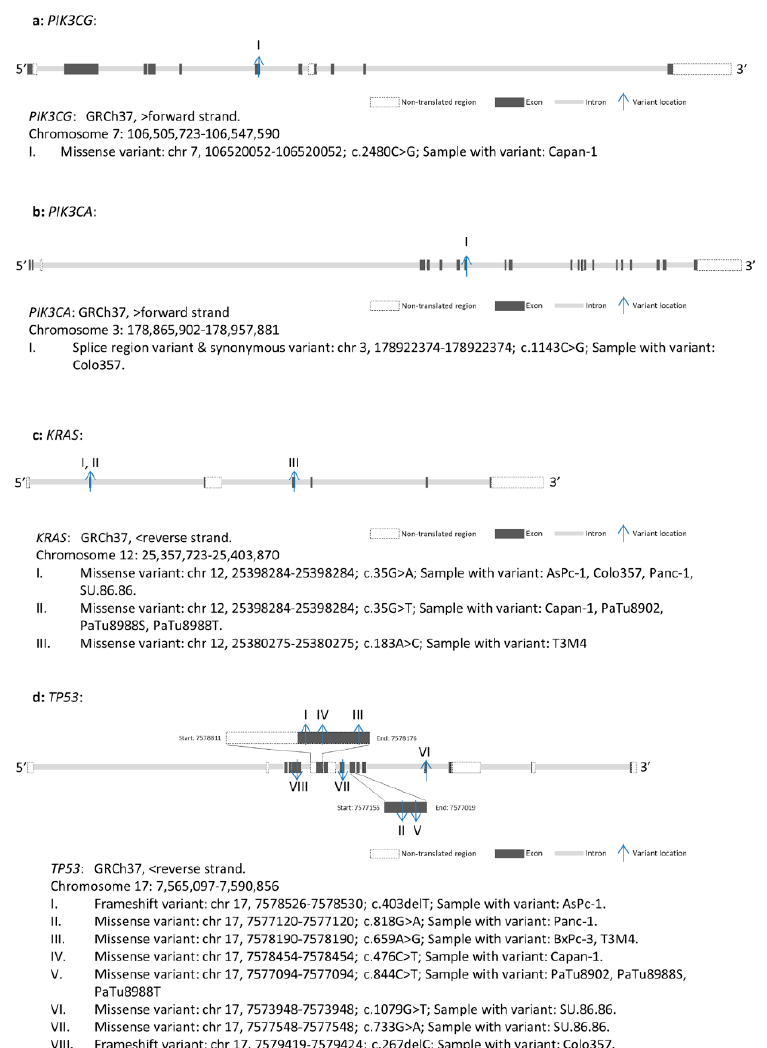
Figure 4. Gene maps indicating the variant positions of PIK3CG ( a ), PIK3CA ( b ), KRAS ( c ), and TP53 ( d ) in different PDAC cell lines. GRCh37: Genome Reference Consortium Human Build 37, Chr: chromosome.